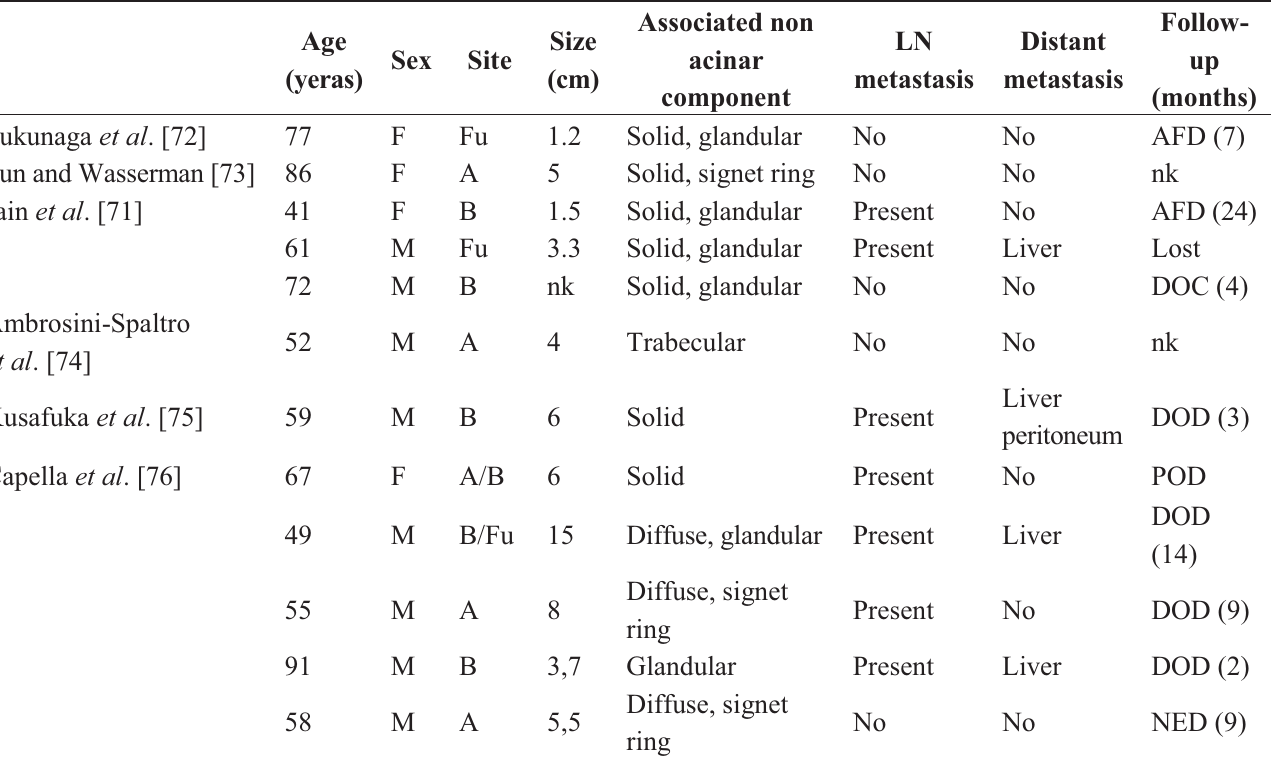
Table 3. Gastric composite glandular and neuroendocrine tumors with pancreatic acinar